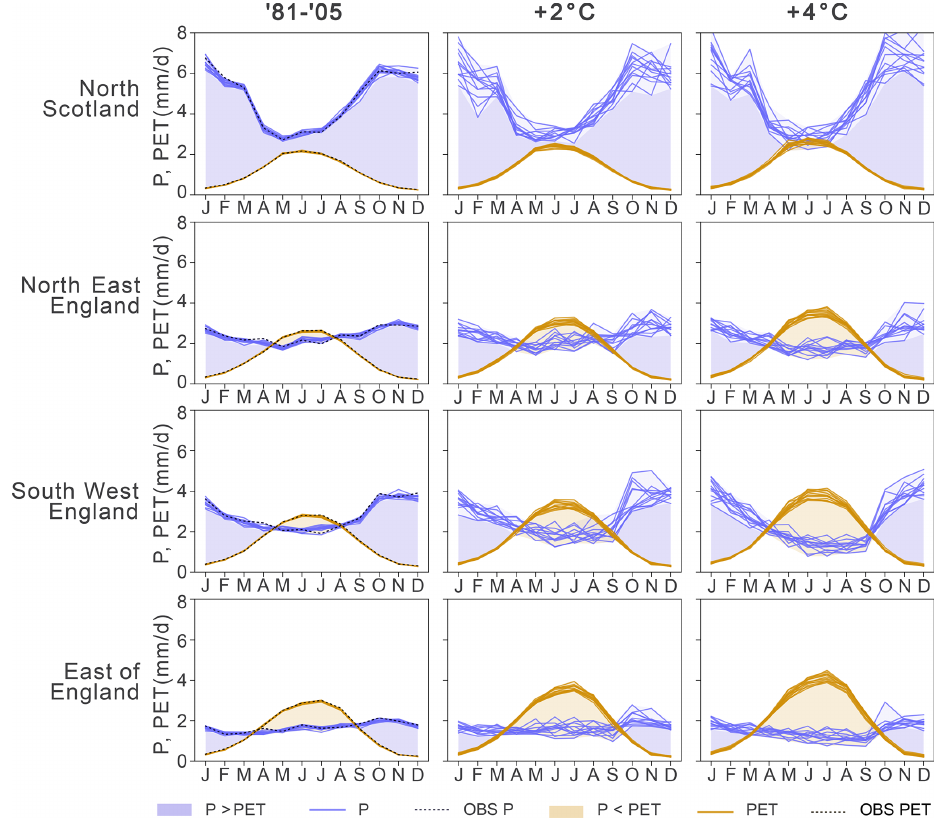
Figure 2. Seasonal cycle of precipitation ( P ; blue lines) and potential evapotranspiration (PET; orange lines) in four selected regions with respect to the 12 bias-adjusted UKCP18 RCM ensemble members. The different lines represent different ensemble members, and the ob- servations are plotted in the first column using darker dashed lines. The reader is referred to Fig. S3 for the seasonal cycles for all 13 regions.